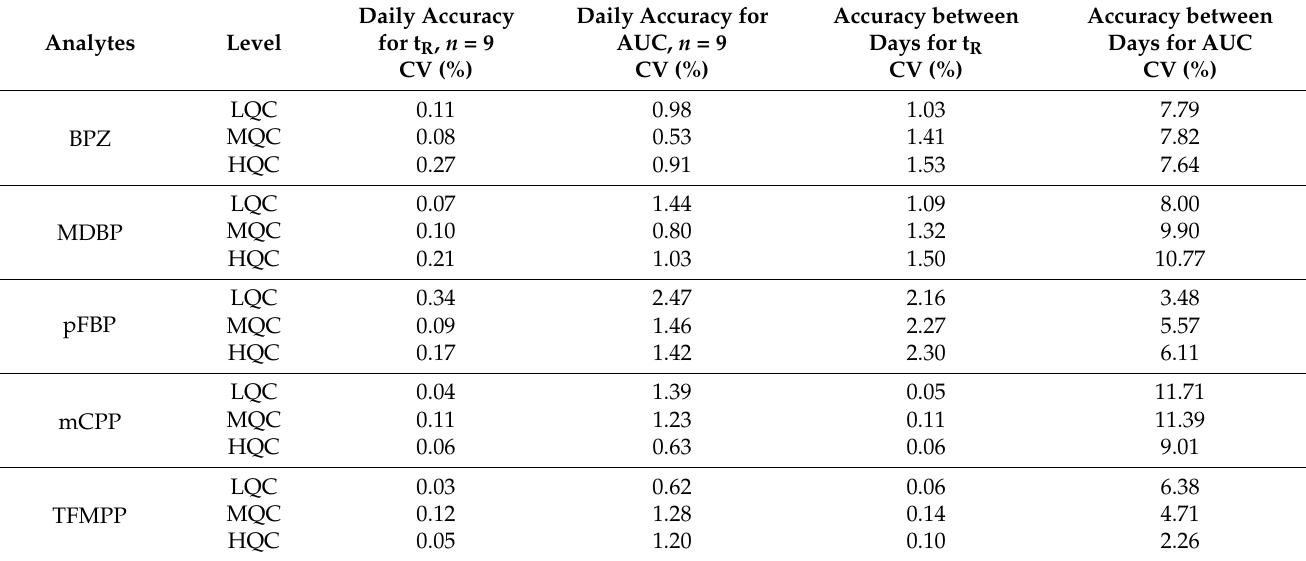
Table 3. Repeatability of the retention times, surface areas of piperazine derivatives during the day and between days, expressed as the coefficient of variation